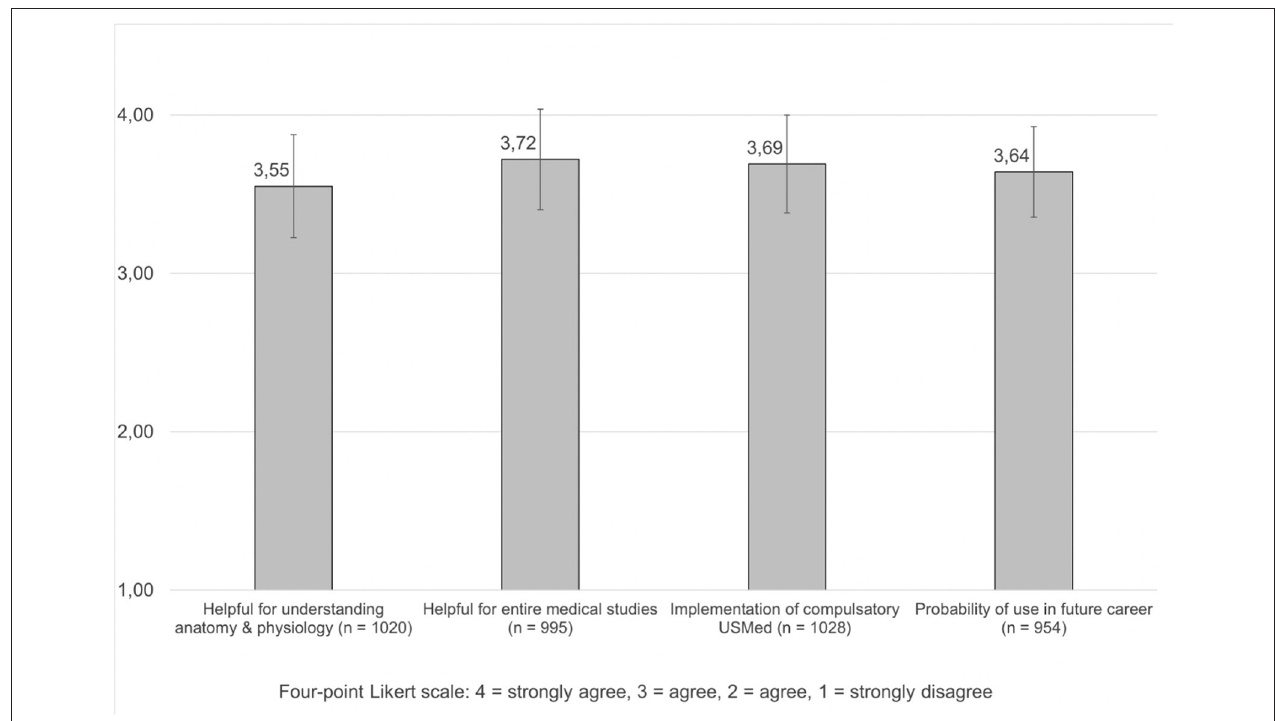
FIGURE 2 | Graph depicting the best starting time for curricular ultrasound courses depending on the medical program type. Numbers are given as percentage.